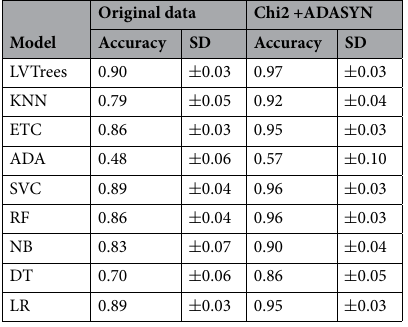
Table 18. Results of 10-fold cross validation for all